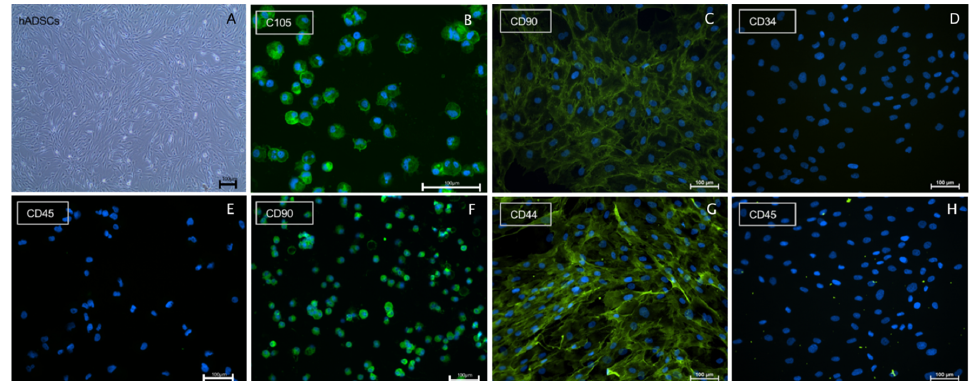
Figure 2. Characterization of human ADSC cultures. Scale bars in ( A – H ) represent 100 µm: ( A ) a bright field image of an ADSC culture in vitro at 80% confluency; ( B – H ) representative immunostainings of human ADSCs cytospins ( B , E , F ) or grown in vitro cultures ( C , D , G , H ); ( B ) CD105 positive immunostaining of ADSCs cytospin; ( C ) CD90 positive immunostaining of grown ADSCs cultures; ( D ) CD34 negative immunostaining of grown ADSCs culture; ( E ) CD45 negative immunostaining of ADSC cytospin; ( F ) CD90 positive immunostaining of ADSC cytospin; ( G ) CD44 positive immunostaining of ADSCs in culture; and ( H ) CD45 negative immunostaining of ADSCs cultures.